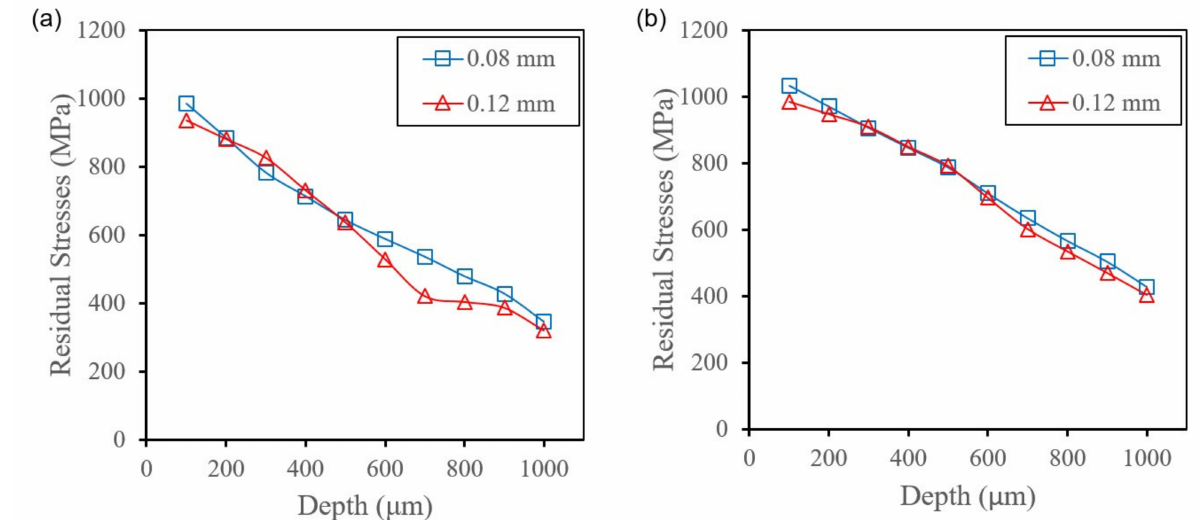
Figure 45. Effect of hatch spacing on in-depth RS at 650 mm/s and ( a ) 220 W and ( b ) 140 W. Examining the effect of laser power on the in-depth RS and deflection show that increasing the laser power from 140 W to 270 W decreases the in-depth RS, as seen in Figure 46. However, the generated RS for all three laser powers are highly tensile down to a depth of 1 mm from the surface. This trend is similar to that predicted from the layer model for the surface RS, as presented in Section 4.2.3. Increasing the scan speed also showed a similar trend to the results reported in Section 4.2.2. The in-depth RS increased with increasing the scan speed, as shown in Figure 47a.